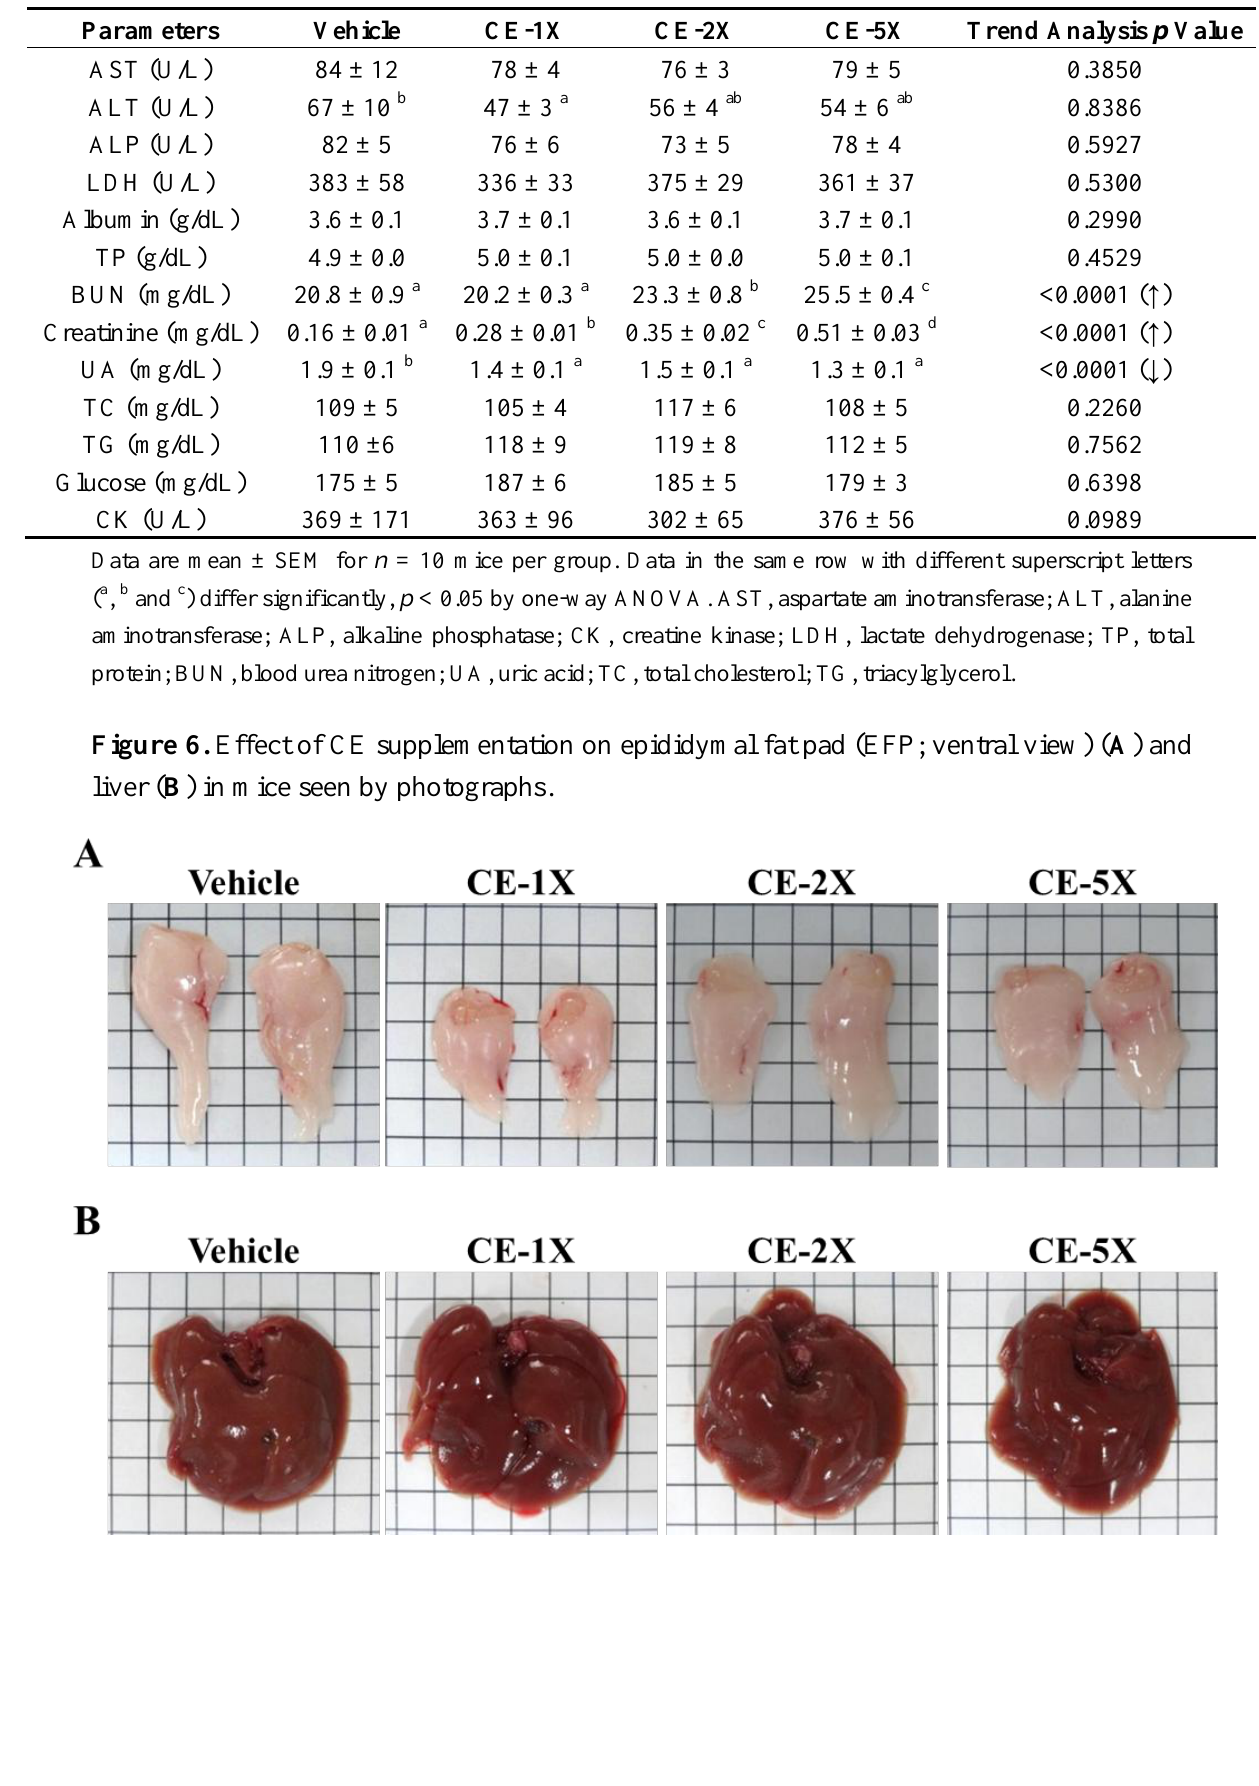
Table 2. Biochemical analysis of vehicle and CE treatment groups at the end of the experiment.